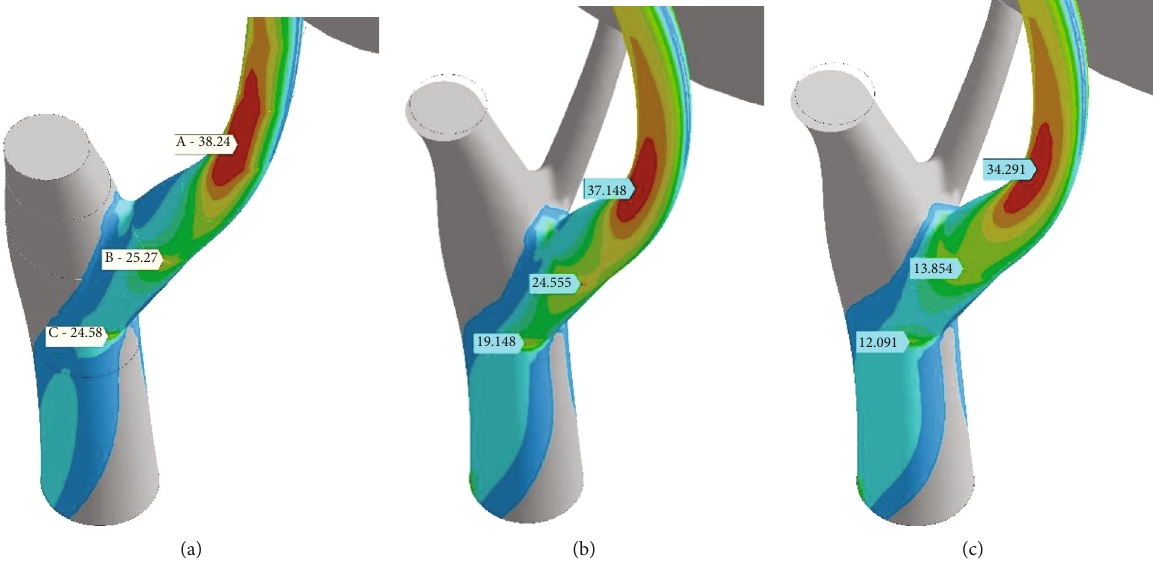
ff erent wood orthotropy models: “ normal-to-split ” wood grain (a), vertical- Figure 13: Distributions of the equivalent stress ( σ e ) for di dominant wood grain (b), and “ along main branch ” wood grain (c). Pressure ð p wind norm Þ = 380 Pa, leeward; (a, b) ChestWH and (c) ChestTKP; Lin; × 1.